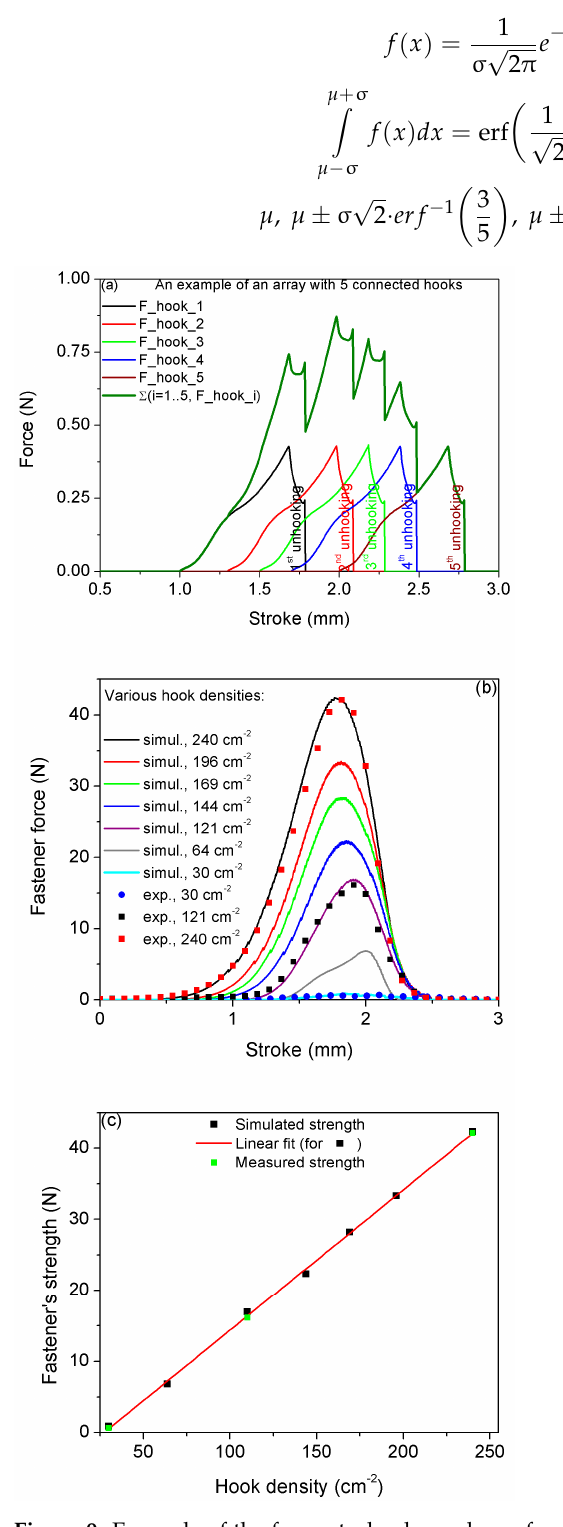
Figure 9. Example of the force-stroke dependence for an array with five connected hooks ( a ), the simulated/measured NiTi Velcro-like fastener’s force versus stroke for various hook densities ( b ) and the simulated/measured fastener’s strength versus hook density ( c ).